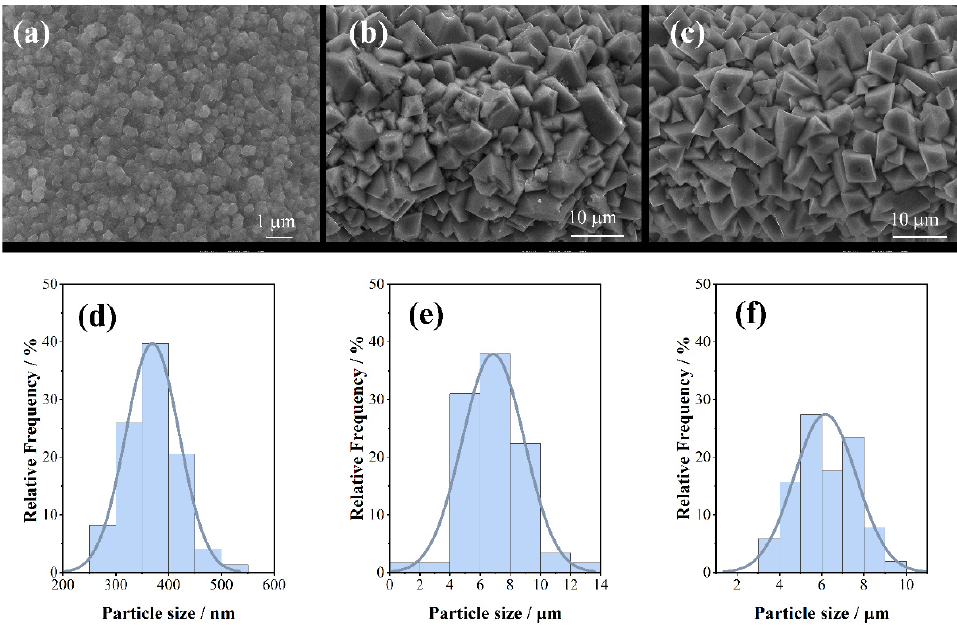
Figure 7. SEM micrographs and particle size distribution of ZnMn 2 O 4 spinel prepared for ( a , d ) 6 h, ( b , e ) 12 h, and ( c , f ) 18 h.